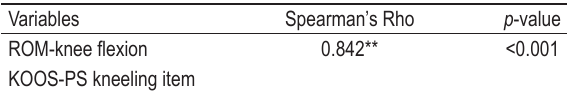
TABLE 5. Spearman correlation coefficient (Spearman’s Rho)